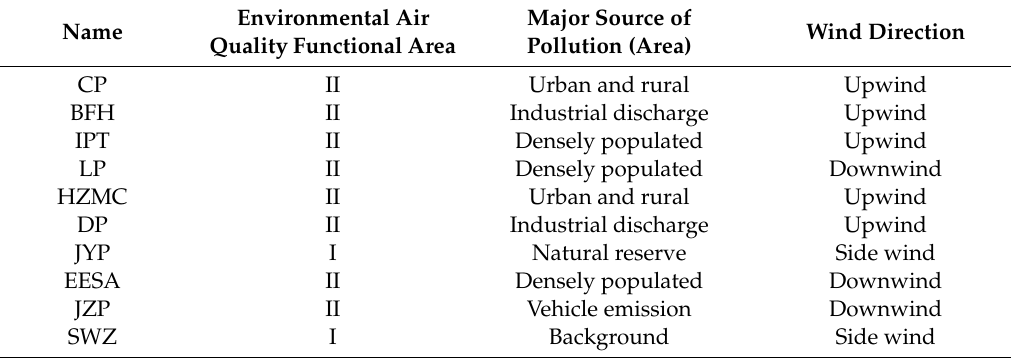
Figure 1. Air monitoring stations of Changchun, as well as the annual average concentration and five-year average concentration of O 3 for each monitoring station in 2013–2017. Table 1. Basic information of the air monitoring stations in Changchun.